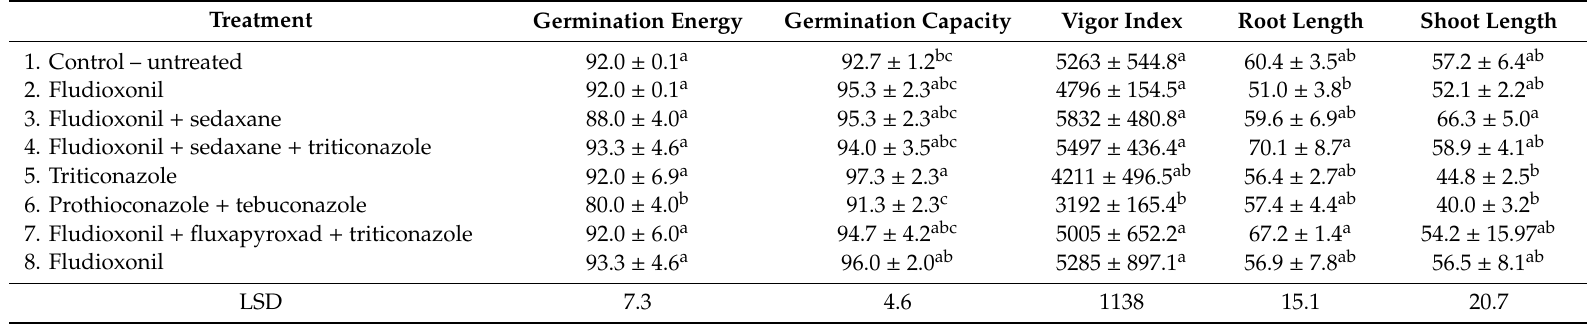
Table 2. Impact of applied treatments on germination energy, germination capacity, vigor index, root and shoot length of spring barley